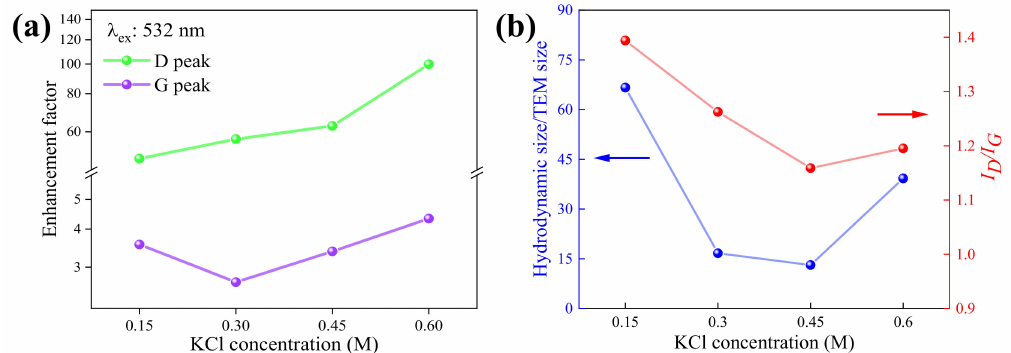
Figure 7. ( a ) Enhancement Factor of D and G peaks at various electrolyte concentrations, and ( b ) I D /I G and the size ratio between the hydrodynamic layer size and TEM size at various